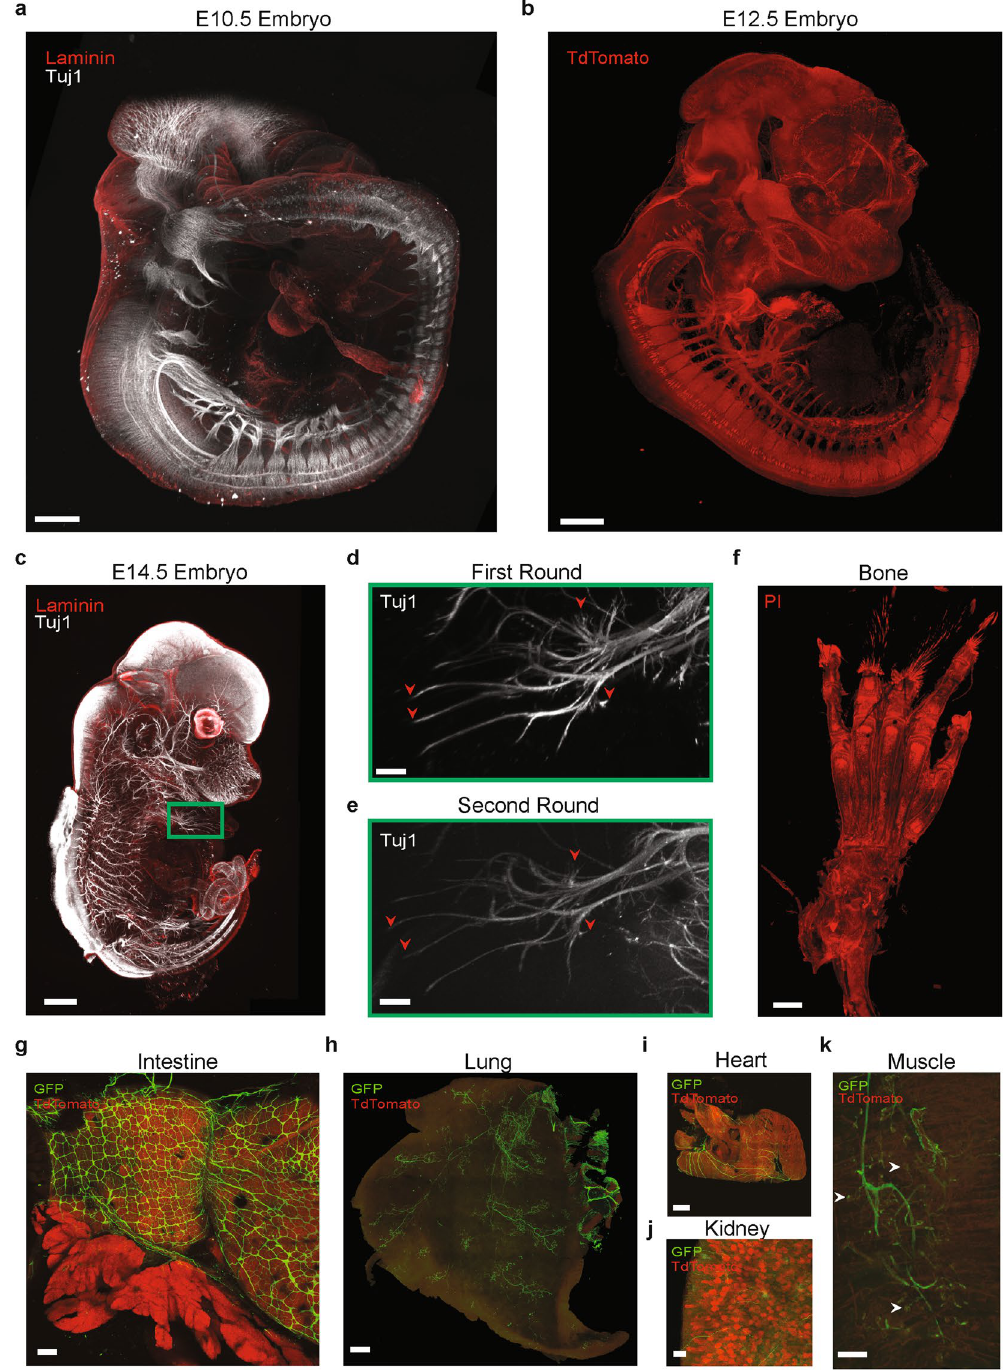
Figure 6. Applications of CLARITY to diverse biological systems. ( a ) Wildtype E10.5 mouse embryo was cleared and labeled with Tuj1 and laminin. Scale: 500 μ m. ( b ) E12.5 Embryo from Wnt1-Cre x Rosa26/TdTomato mouse was clarified and imaged, demonstrating robust preservation of endogenous labels. Scale: 100 μ m. ( c ) Whole E14.5 mouse embryo was stained for Tuj1 and Laminin, the antibody label removed, and the specimen restained with the same antibody. Scale: 1000 μ m. ( d , e ) Even after two rounds of staining, the same fine structural features (arrowheads) can be easily identified in the whole sample (green box). Scale: 200 μ m. ( f ) CLARITY can successfully clear decalcified bone (see Methods). Scale: 1000 μ m. Samples in panels a-f were embedded in A1B1P4 hydrogel and cleared for 2–4 weeks at 37 °C (see Methods and detailed protocol for tissue- dependent timing). ( g – k ) Other whole organs can also be cleared, including the gastrointestinal tract (here, pyloric sphincter, scale: 500 μ m), lung (scale: 500 μ m), heart (scale: 1000 μ m), kidney (scale: 100 μ m), and skeletal muscle (scale: 50 μ m). CLARITY preserves fine structures, enabling visualization of, for example, neuromuscular junctions (arrowheads). Samples in panels ( g – k ) were from adult Wnt1-Cre; Rosa26-mT/mG reporter lines, embedded in A4B4P0 hydrogel and clarified for 1–2 wk at 37 °C (see detailed protocol for tissue-specific